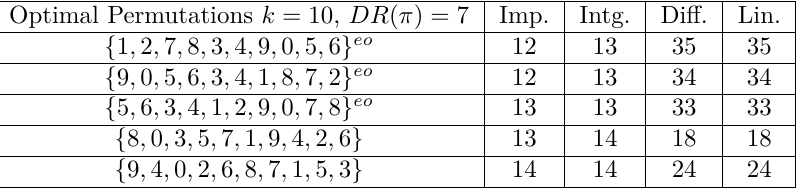
Table 12: Optimal permutations for k = 10 up to extended pair-equivalence Optimal Permutations k = 10, DR ( π ) = 7 Imp. Intg. Diff. Lin. { 1 , 2 , 7 , 8 , 3 , 4 , 9 , 0 , 5 , 6 }